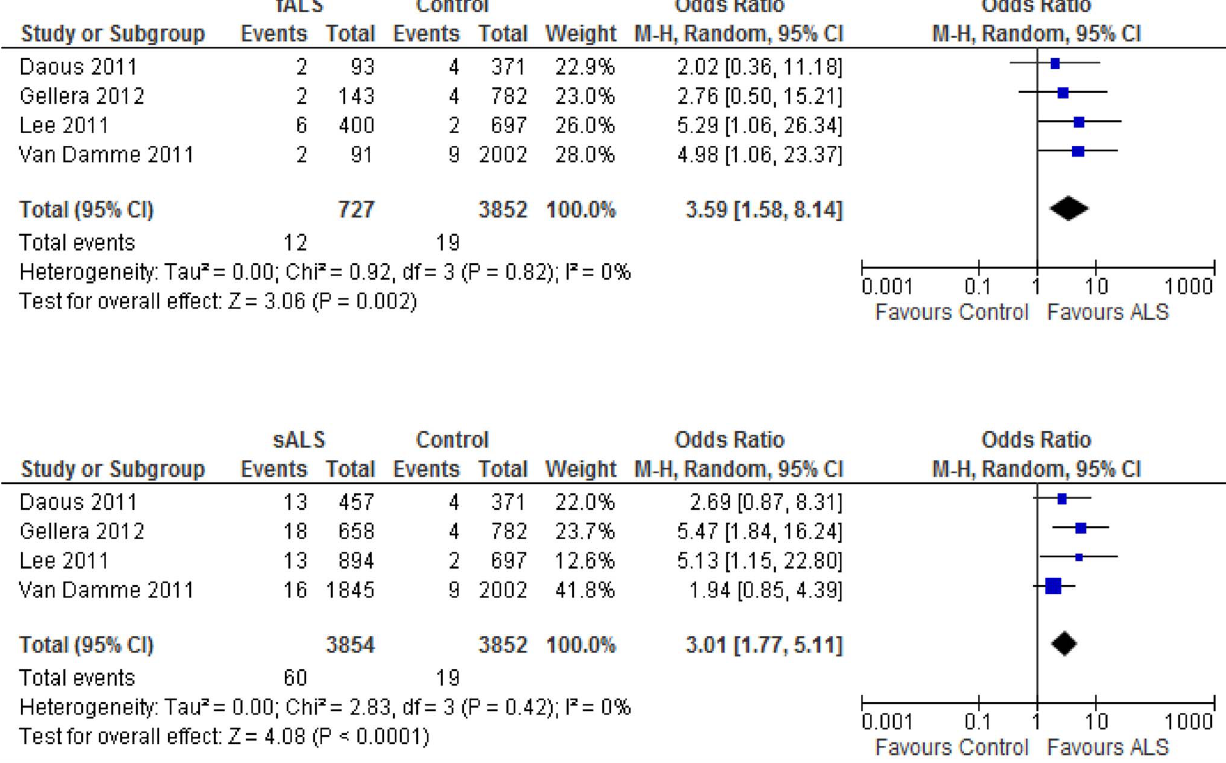
Figure 5. The synthesized OR of the presence of intermediate CAG repeats with meta-analysis is not different from FALS and SALS cases in the ATXN2 gene. The relative risks (OR) among fALS cases (top panel) or sALS cases (lower Panel) compared to controls were synthesized with meta-analysis using extracted data from 4 included case-control studies. The results from random effects model were presented. Similar results were also obtained when use fixed effects model (data not shown).